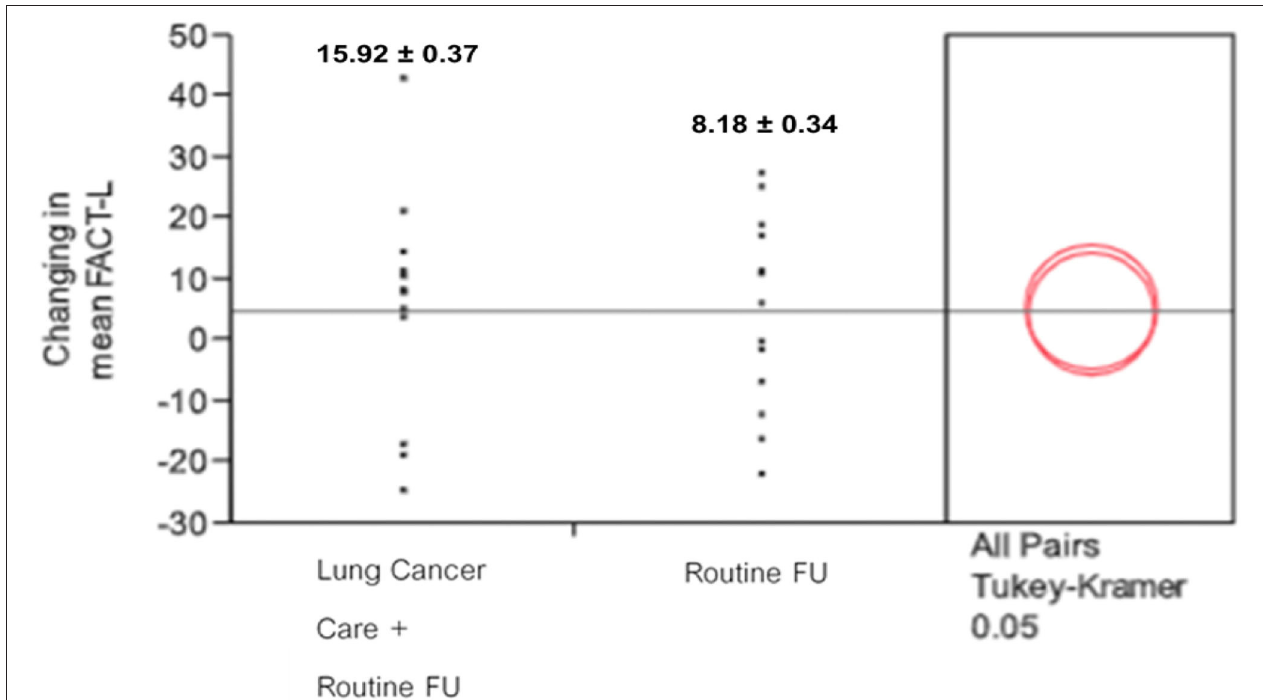
FIGURE 5 | Changing in mean of FACT-L score between 2